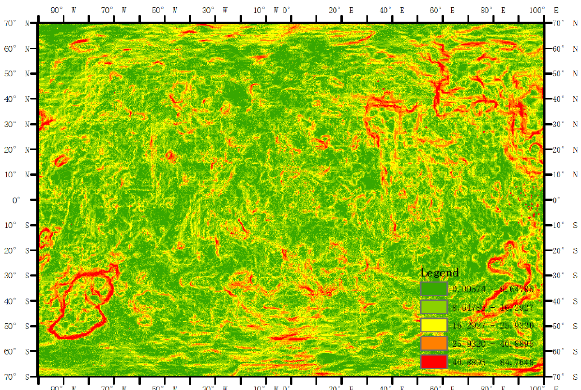
Figure 11. Slope map of the simulated asteroid